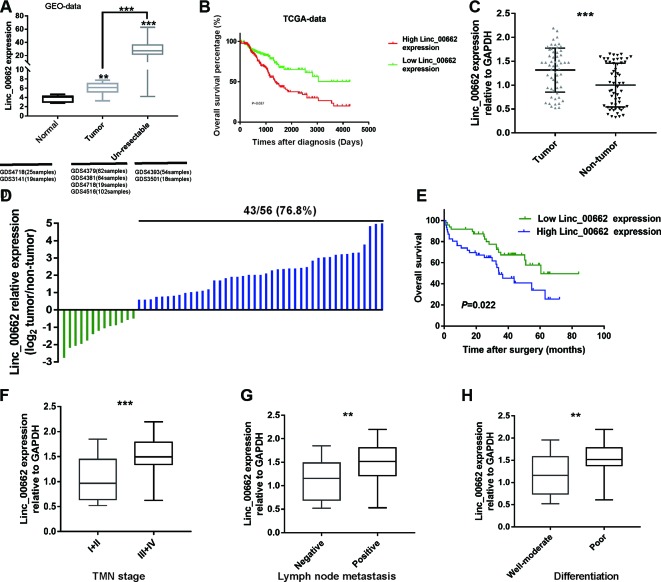
Linc00662 is elevated in CRC tissues relative to normal tissues. (A) The linc00662 expression data in CRC tissues were obtained from GEO datasets. Analysis revealed that CRC tissues have higher linc00662 expression level than normal tissues, especially in unresectable tumor tissues. (B) The Kaplan-Meier method was used to calculate the curves. CRC patients with high linc00662 expression have shorter overall survival, shown in TCGA-COAD RNA-Seq dataset within the GEPIA database. (C) Relative expression of linc00662 in 56 pairs of CRC tissues compared to corresponding adjacent normal tissues. (D) linc00662 expression in 56 pairs of CRC and corresponding normal tissues. (E) Relative expression of linc00662in CRC patients with lymph node metastasis. (F) Relative expression of linc00662 in CRC patients with differentiation. (G) Relative expression of linc00662 in CRC patients with different TNM stages. (H) The linc00662 low expression group had a longer survival time than the high expression group. **P < 0.01, ***P < 0.001.